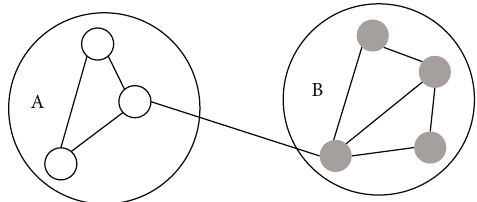
Figure 1: An example of nonoverlapping community structure.